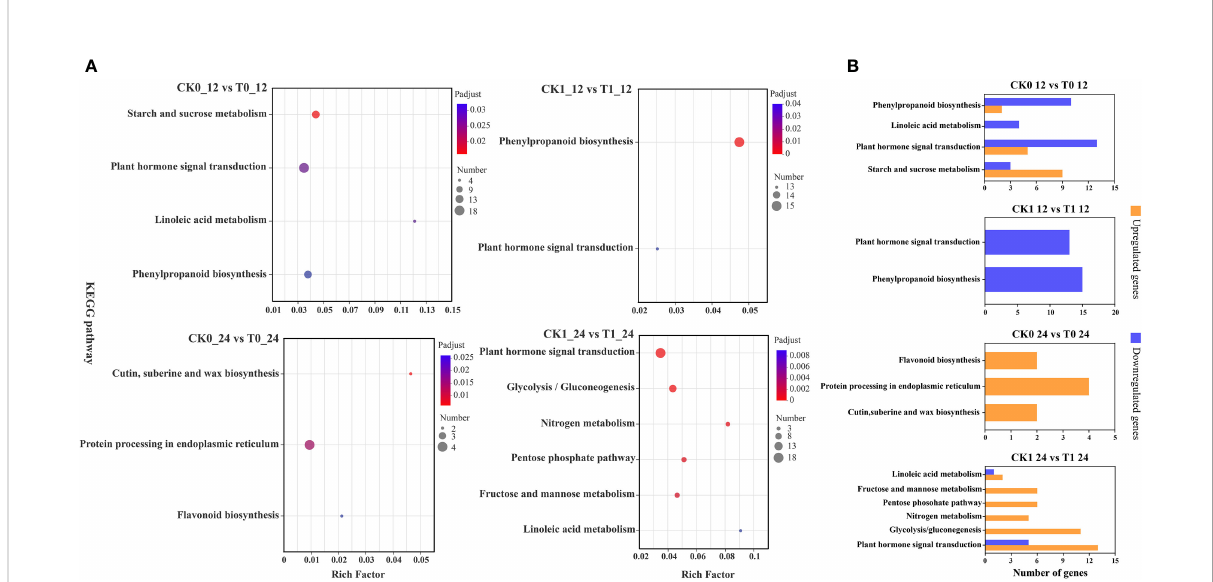
FIGURE 6 KEGG enrichment analysis of DEGs (A) , up- and down-regulated DEGs in KEGG pathways (B) . p -adjust < 0.05 was considered to be signi fi cantly different.